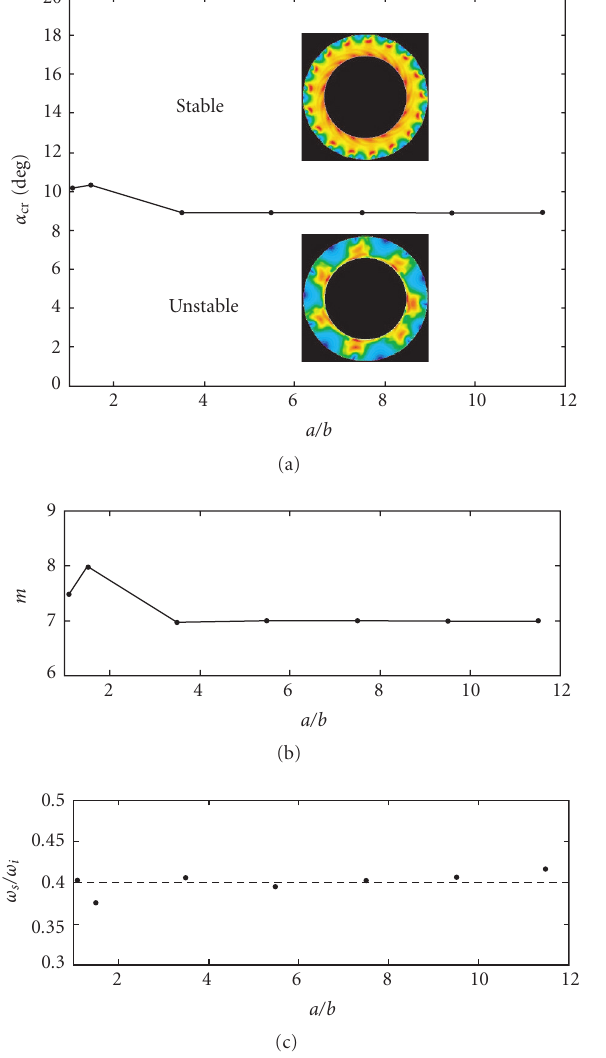
Figure 9: (a) The critical flow angle, (b) number of rotating cells, and (c) their relative propagation speed versus a/b ratio.